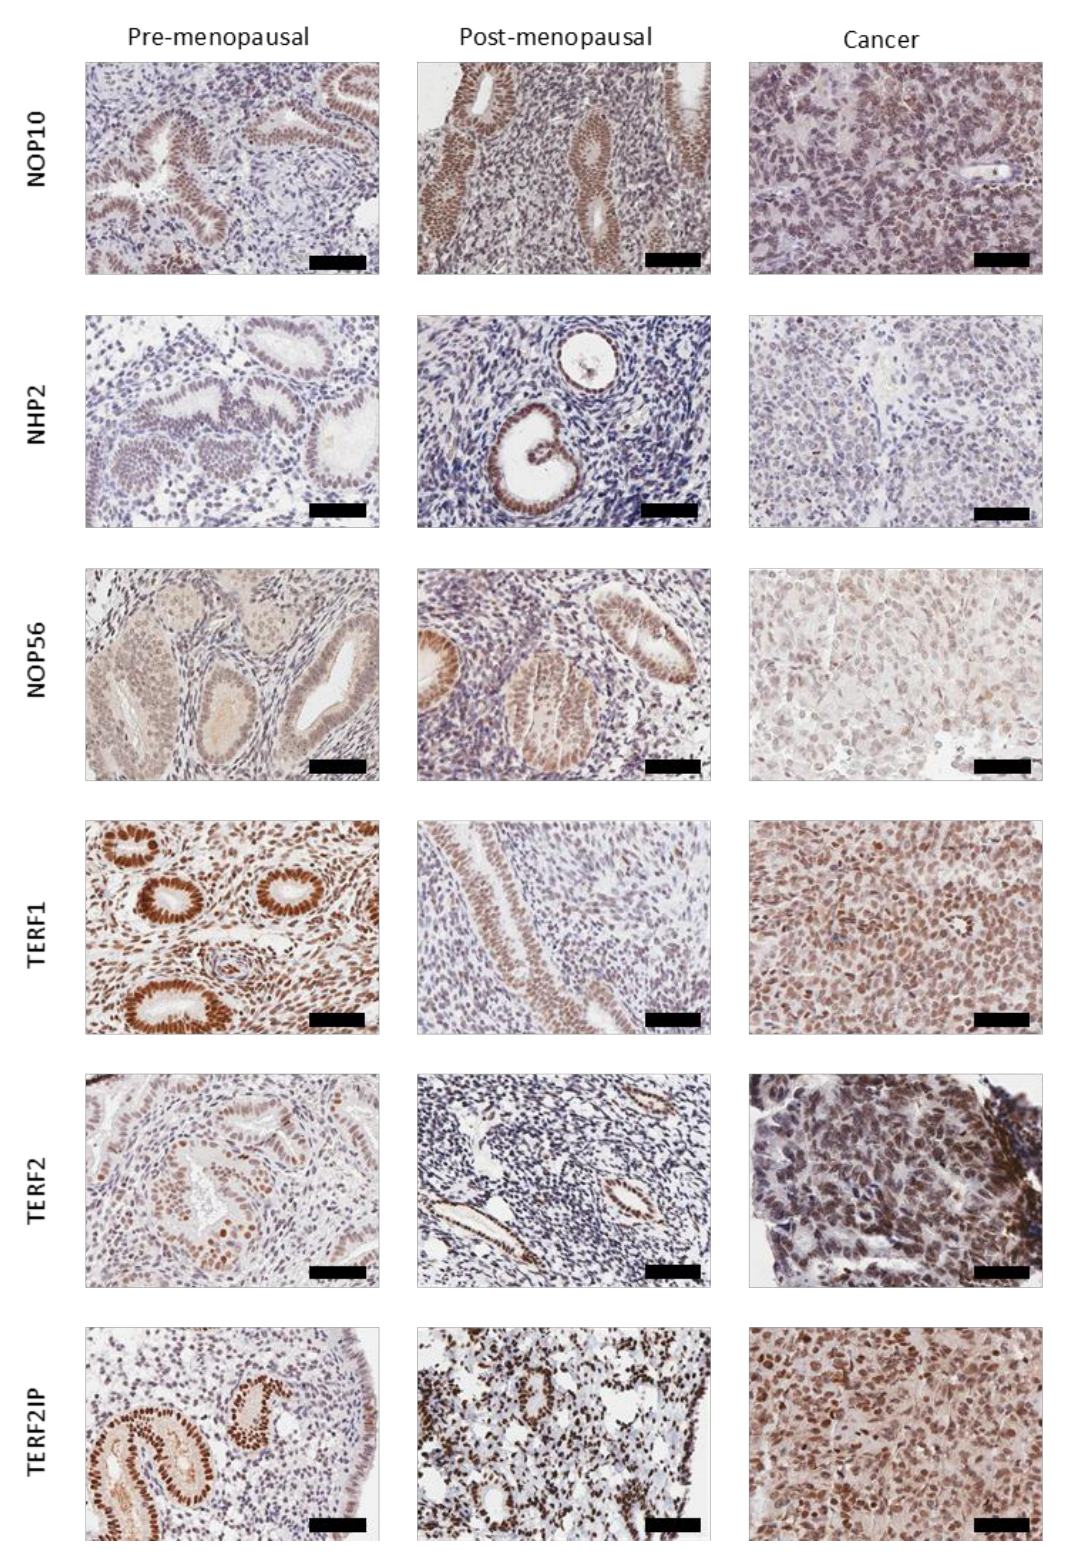
Figure 4. Representative photomicrographs of NOP10, NHP2, NOP56, TERF1, TERF2 and TERF2IP immunohistochemical staining in human endometrial samples from pre-menopausal, post-menopausal and cancer patients. Magnification 40×, scale bar is 60 microns. Positive staining appears brown.